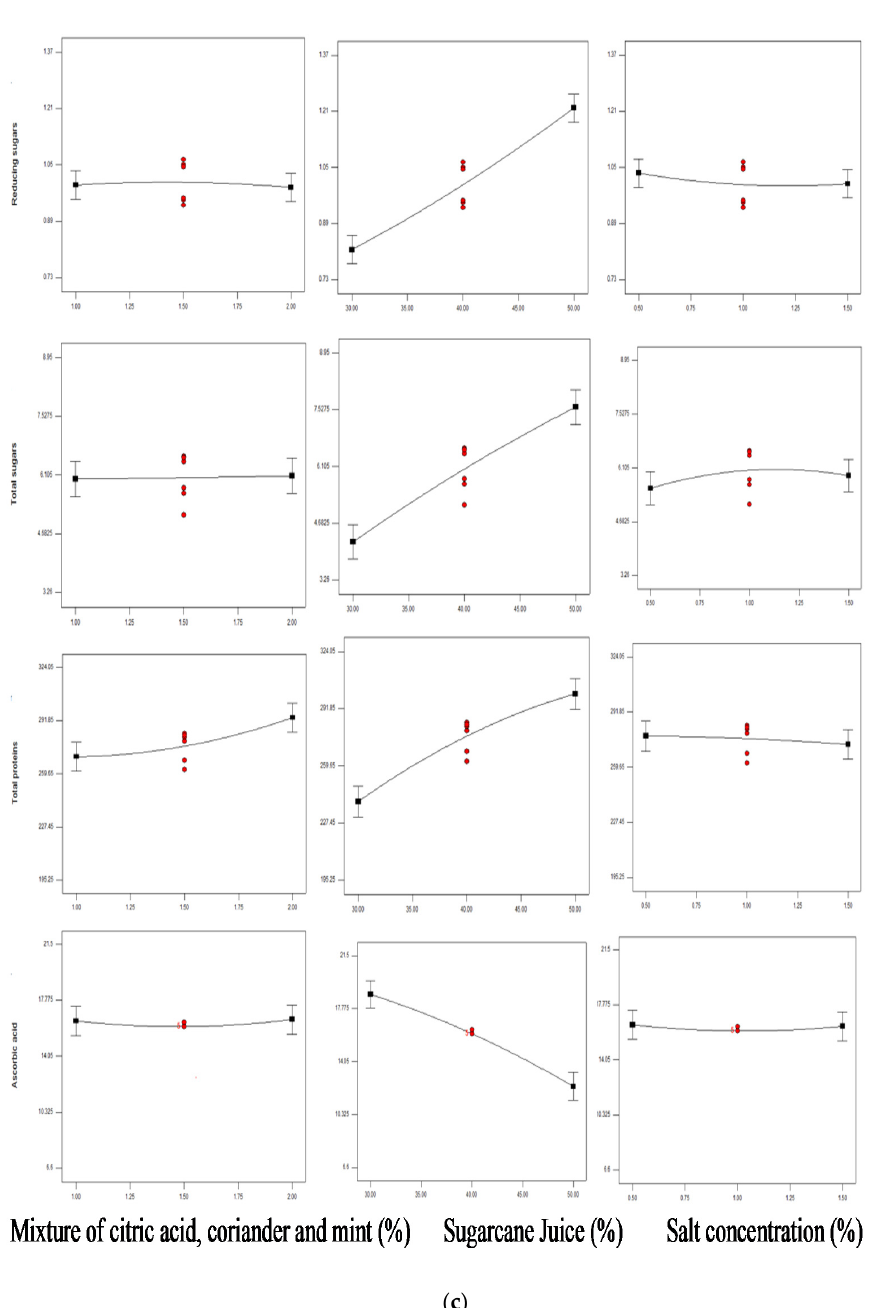
Figure 1. Influence of each processing variable on the response variables when other processing variables are held constant; numbers next to the X and Y axes labels correspond to the value of each variable at the red dotted point. ( a ) Influence of each processing variable on phytochemical attributes; ( b ) Influence of each processing variable on quality parameters; ( c ) Influence of each processing variable on nutritional parameters